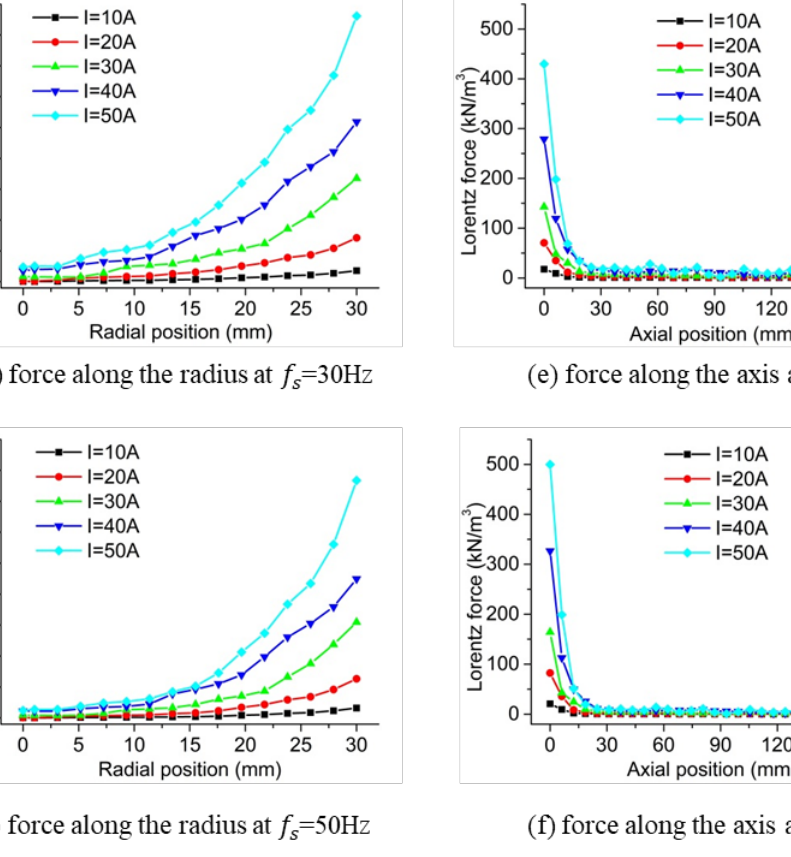
Figure 10. Results of the Lorentz force at different winding currents and electrical frequencies.